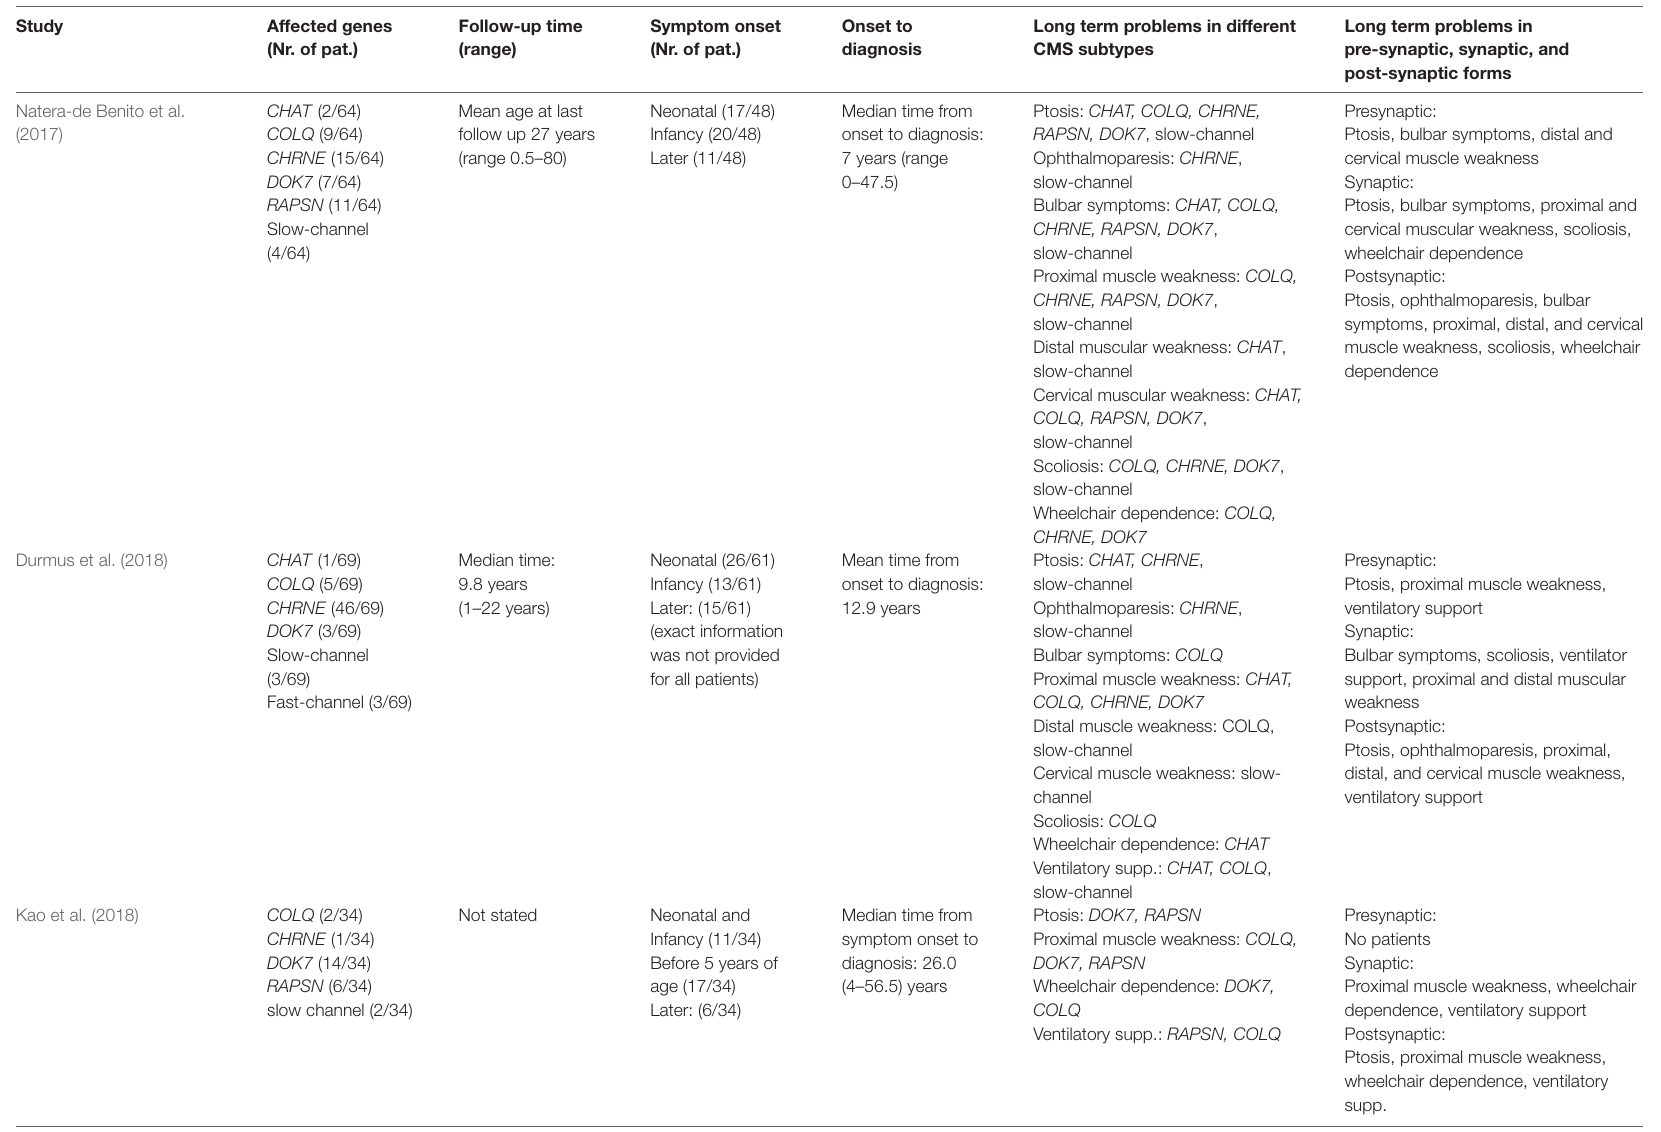
TABLE 3A | Comparison of findings in different CMS cohorts. Only patients with defects in genes also identified to be mutated in our cohort have been extracted from the different studies. Comparison of adult and mixed cohort patients and our cohort including follow-up time, point of symptom onset, time of diagnosis, and clinical symptoms depending on underlying mutation and characterization depending on the functional position on